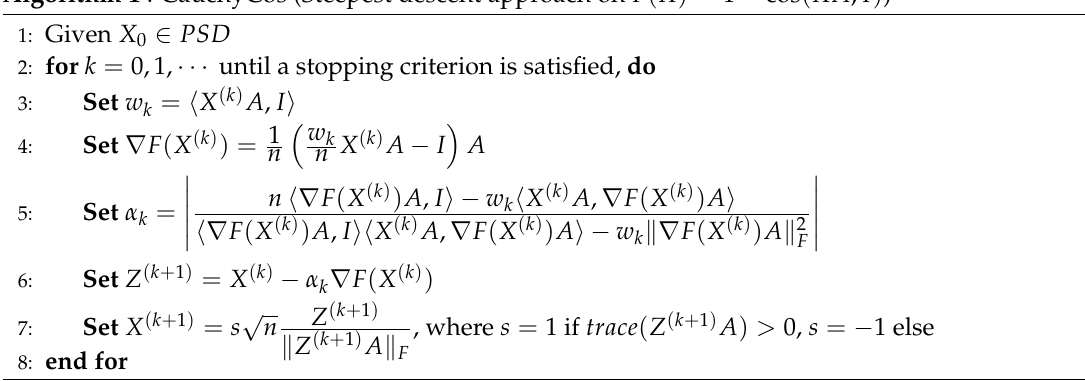
Algorithm 1 : CauchyCos (Steepest descent approach on F ( X ) = 1